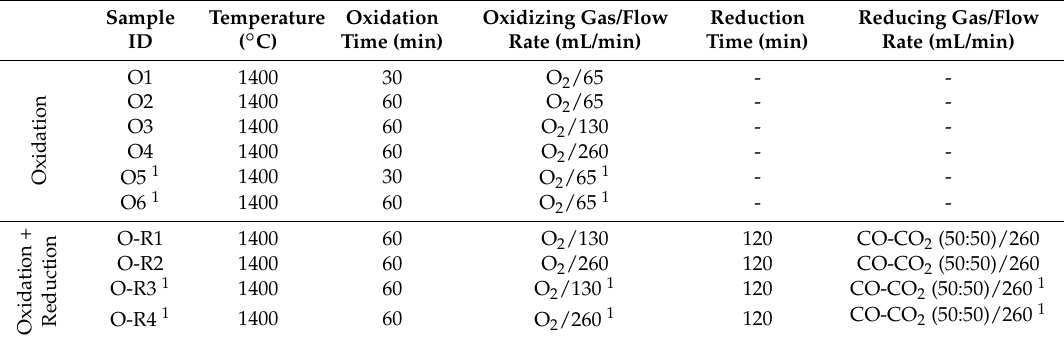
Table 1. Experimental parameters used in the oxidation and oxidation-reduction